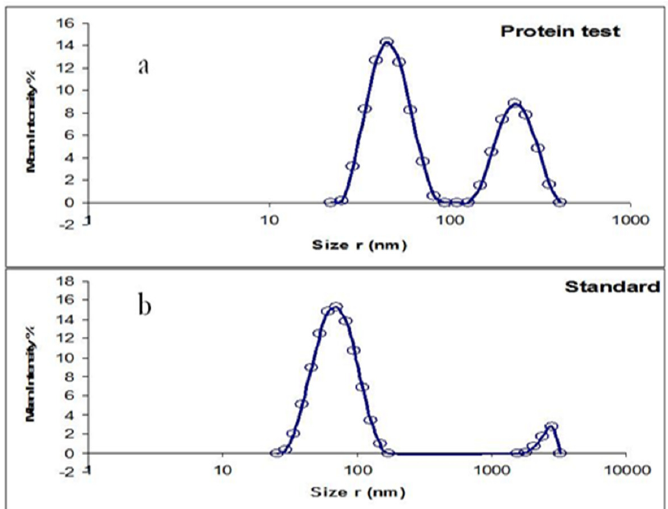
Figure 6. The particle size of standard desferal (a) and extracted siderophore from Pseudomonas sp